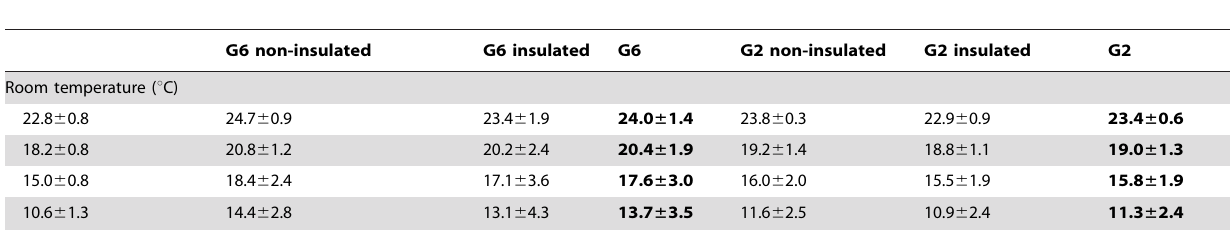
Table 1. Mean ( 6 SD) ambient temperatures experienced by different categories of pup groups in the chambers (G6 or G2 pups, non-insulated and insulated) as a function of the cold challenge in the experimental room.